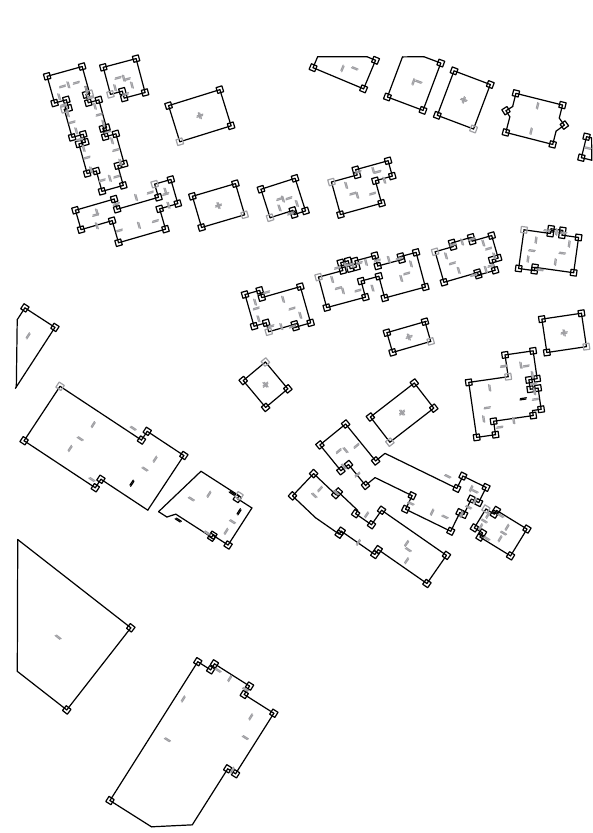
Figure 7. Interactively acquired building outlines with 250 straight line segments constrained by 420 geometric constraints. Redundant constraints are denoted by gray symbols.